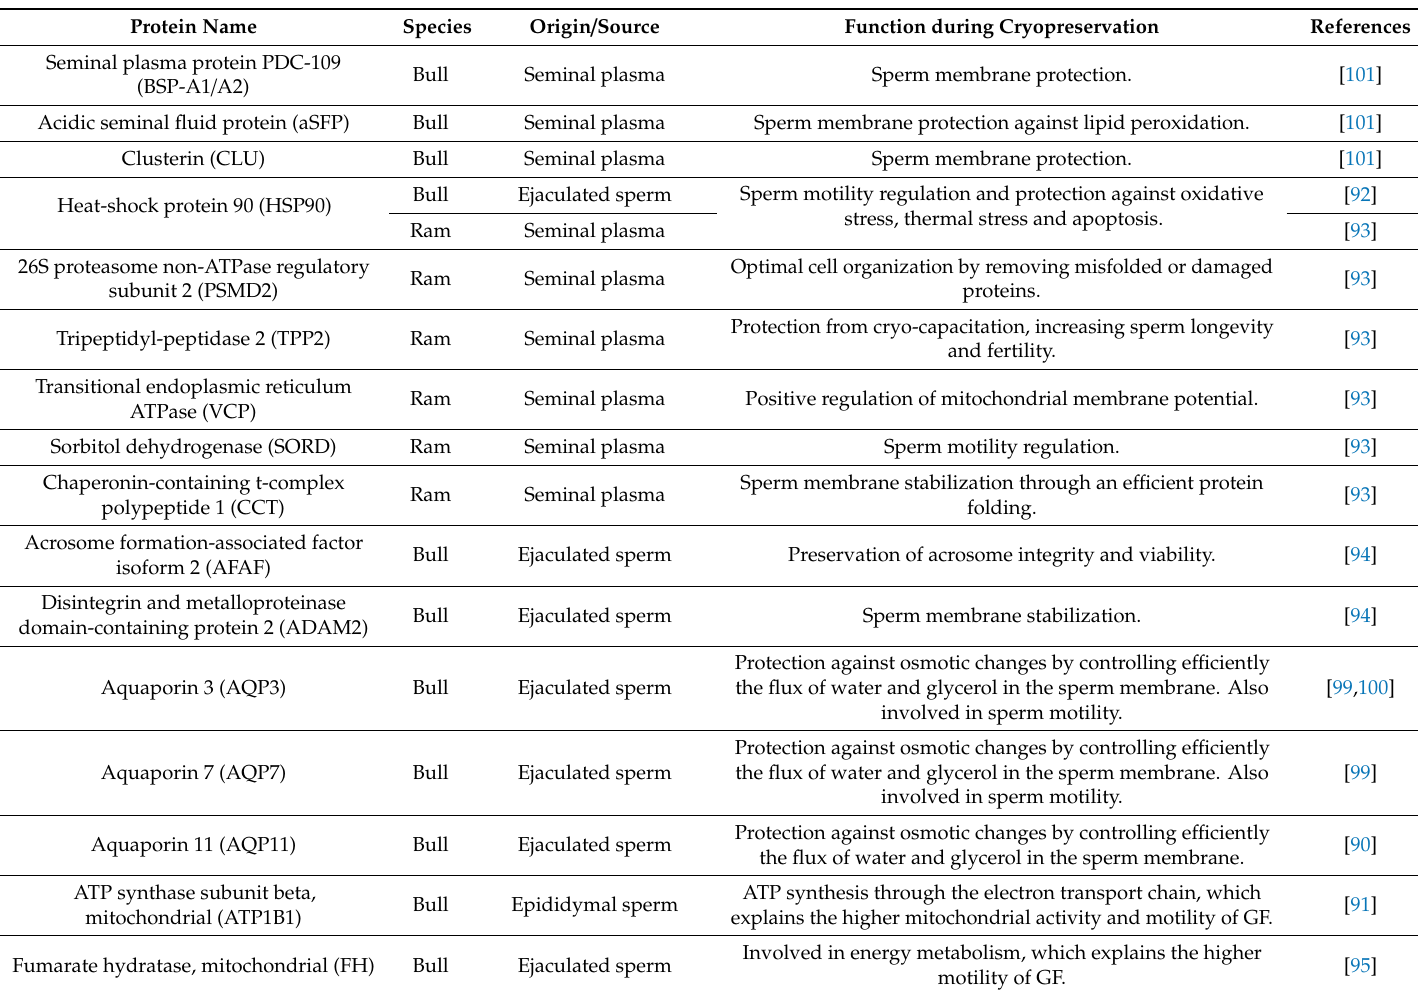
Table 1. Proteins that can be used as biomarkers to predict sperm freezability in ruminants due to their higher abundance in good freezers (GF) compared to bad freezers